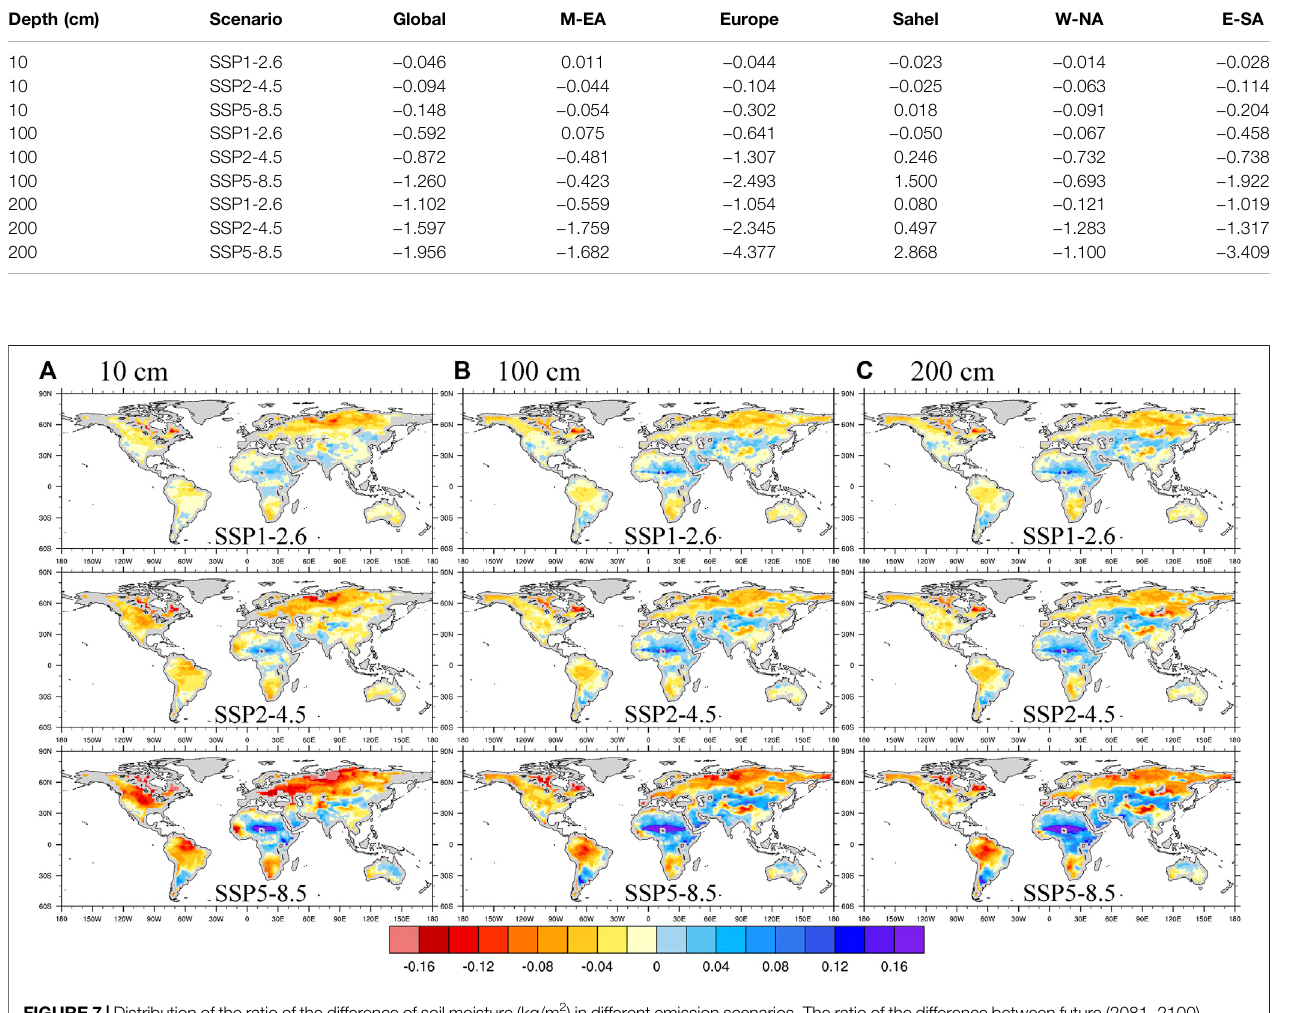
FIGURE 7 | Distribution of the ratio of the difference of soil moisture (kg/m 2 ) in different emission scenarios. The ratio of the difference between future (2081 – 2100) and historical (1995 – 2014) climatological soil moisture [the ratio (cid:1) (future − historical)/historical]. (A) , (B) , and (C) Shallow (10 cm), middle (100 cm), and deep (200 cm) soil moisture,